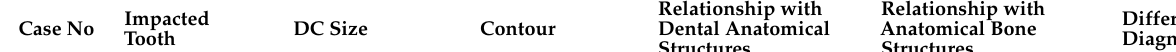
Table 1. Summary of the features of the presented